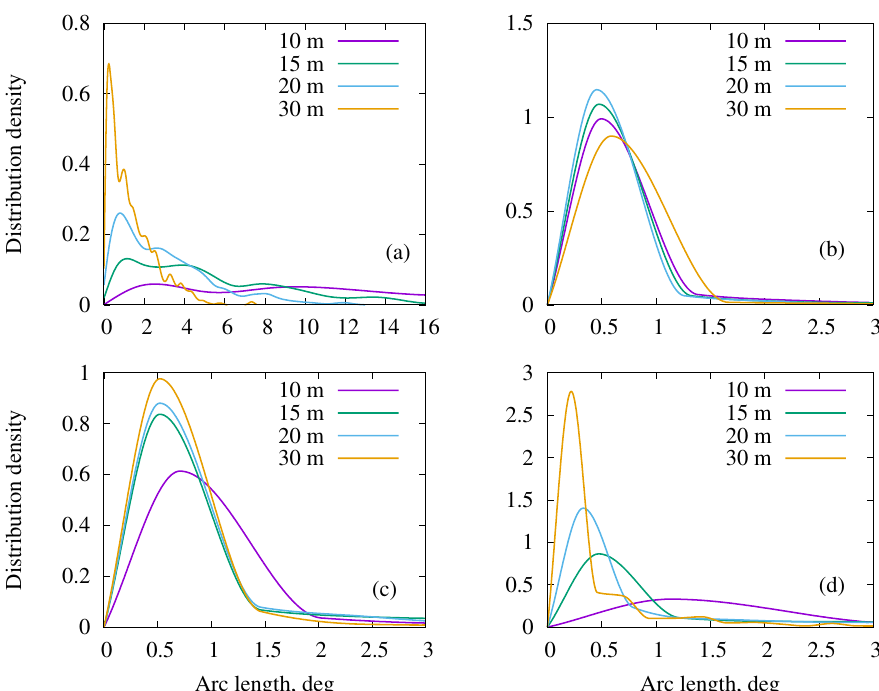
Figure 7. Distribution of open arc length at different distances in the birch stand: ( a ) simulation; ( b ) Leica TLS measurements, 2013; ( c ) Leica TLS measurements, 2019; and ( d ) Trimble TLS measure- ments, 2019.